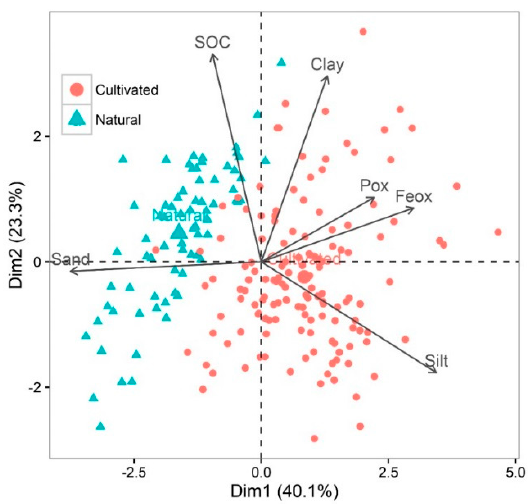
Figure 3. Principal component analysis incorporating measured variables by soil system . Pox, oxalate-extractable P; Feox, oxalate Fe; SOC, soil organic carbon.